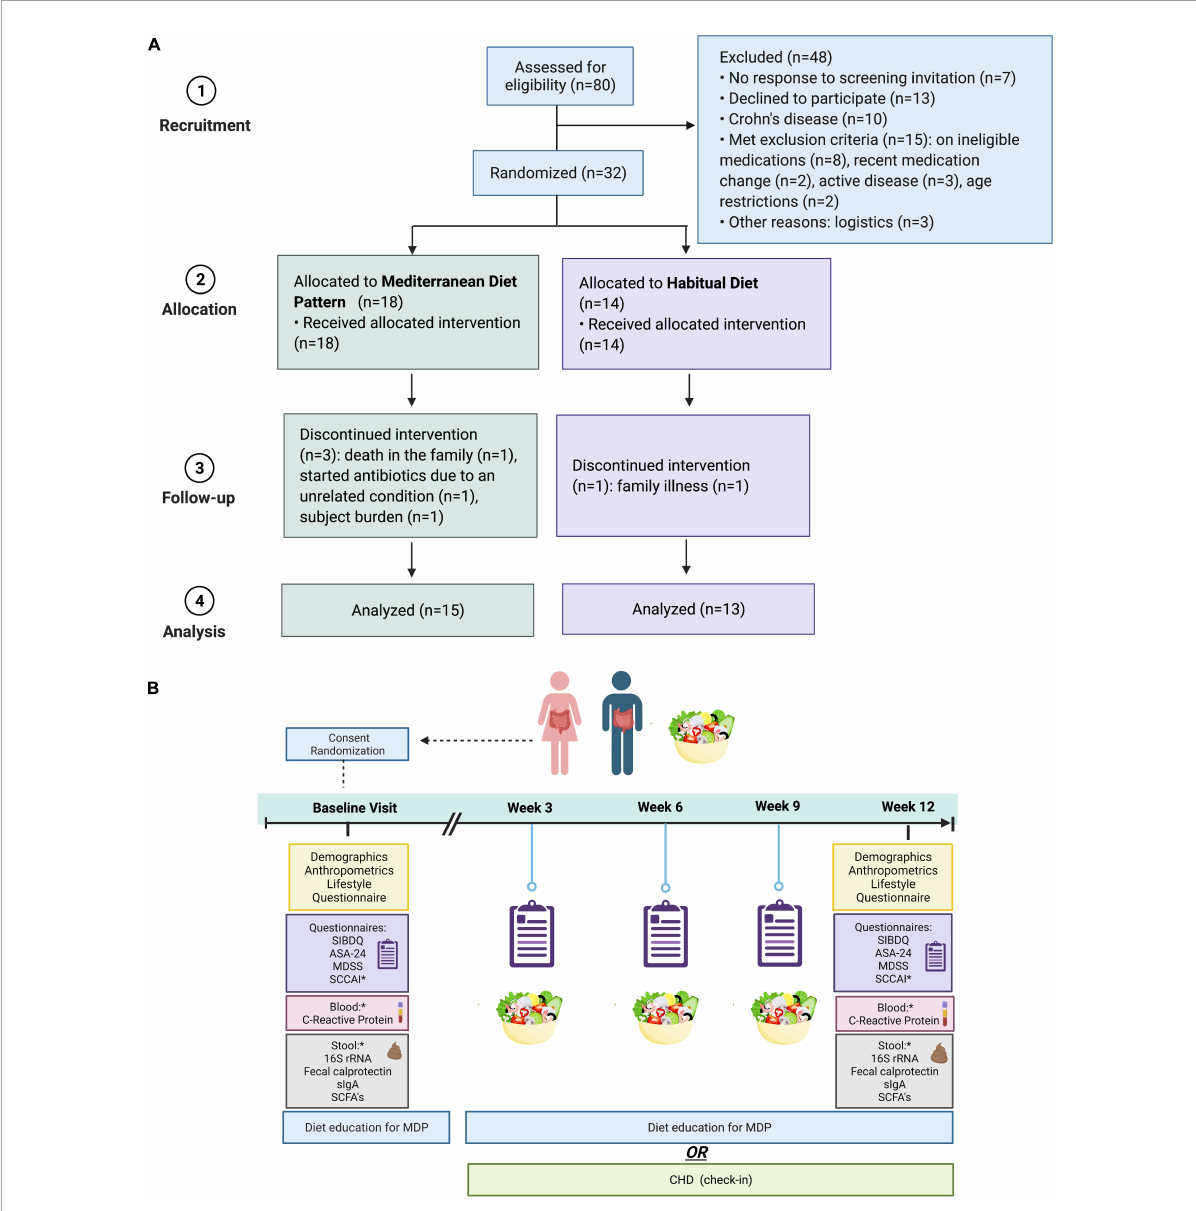
FIGURE1 (A) Flow chart of recruitment. (B) Summary of the 12-week intervention of the MDP vs. CHD in patients with quiescent UC. SIBDQ, short inflammatory bowel disease questionnaire (quality of life); ASA-24, 24-h dietary recall; MDSS, Mediterranean diet serving score (compliance); SCCAI, Simple Clinical Colitis Activity Index (disease activity/symptoms); SCFAs, short-chain fatty acids; MDP, Mediterranean diet pattern (intervention); CHD, Canadian habitual diet (control); sIGA, secretory immunoglobulin A. *A component of the larger analysis of the same trial. Graphic prepared with